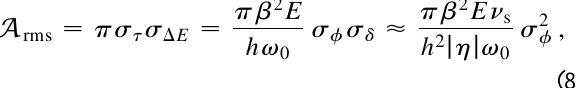
FIG. 2. The evolution of a beam profile after the voltage is jumped to a high value. Each frame is separated by about 83.33 m s or 164 revolutions. Parameters for this run are I avg (cid:1) 670 m A, rf voltage ramp-down time from V 0 (cid:1) 350 V to V 1 (cid:1) 5 V is 27 ms, and the rf voltage is suddenly raised to V 2 (cid:1) 1000 V in about 20 turns. The asymmetry in each beam profile indicated that there was a small dipole mode, i.e., ¯ t 2 t s fi 0 . The dipole mode may arise from the beam loading on the rf